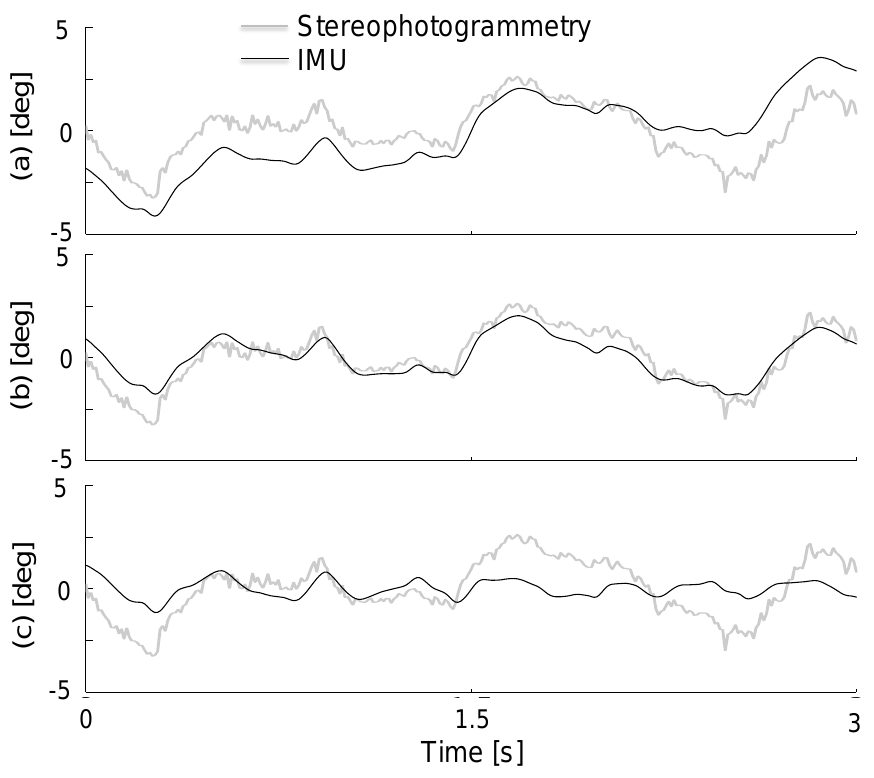
Figure 5. Roll angle, during a randomly selected overground steady-state walking trial, using a trend estimate of the integrated angular velocity using only the final residual ( a ), when IMF is also removed ( b ) and when too many IMFs are removed ( c b